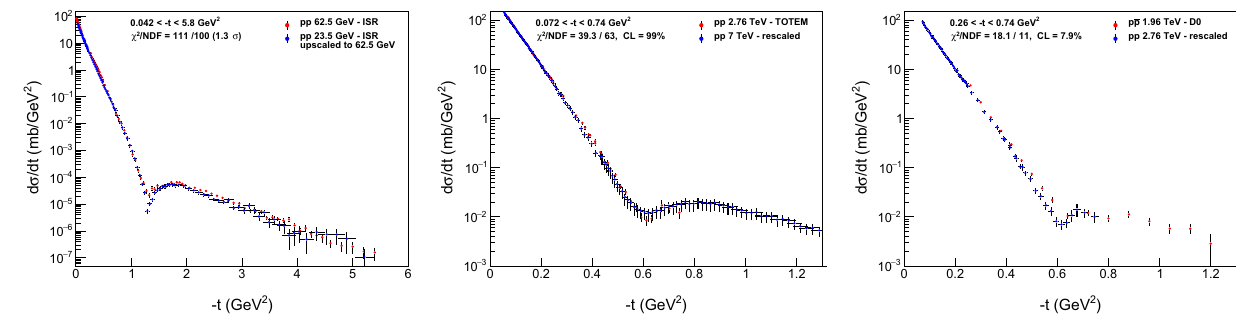
Fig. 7 Rescaling of the differential cross section of elastic pp colli- sions at the ISR and LHC energies, using Eq. (67). This demonstrates that our method can also be used to get the differential cross sections at other energies by such a rescaling procedure, provided that the nuclear slope and the elastic cross sections are known at the new energy as well as at the energy from where we start to rescale the differential cross section. In all panels, we have evaluated the level of agreement between the rescaled and measured data with the help of Eq. (60). Left panel: Rescaling of the differential cross sections from the lowest ISR √ s = 23 . 5 to the highest ISR energy of 62 . 5 GeV. The energy of level of agreement between the rescaled 23.5 GeV pp data and the measured 62.5 GeV pp data corresponds to χ 2 / NDF = 111 . 0 / 110 with a CL = 21.3% , that indicates an agreement within 1.3 σ . Middle